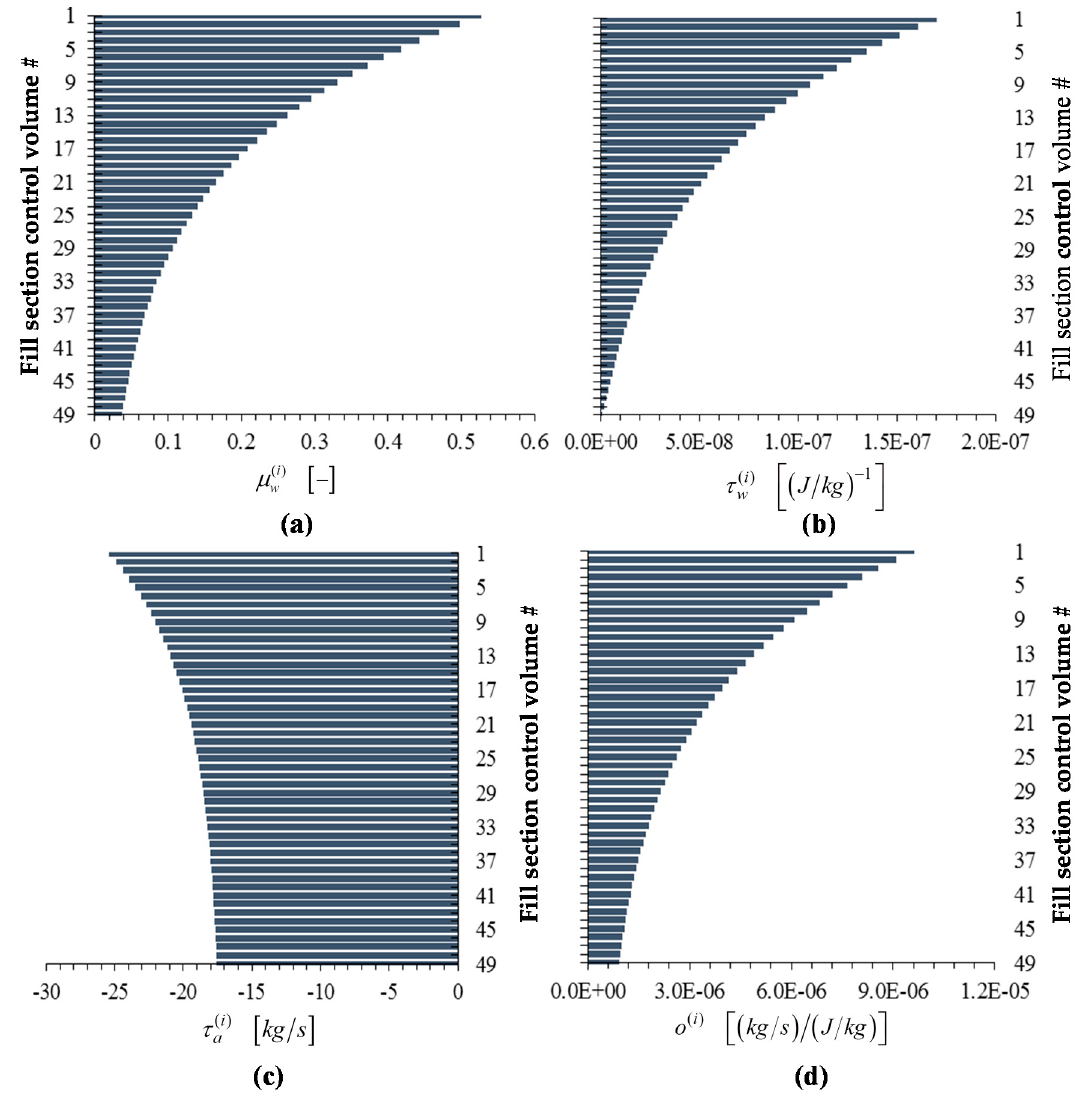
( 50 ) (50)  R m , as functions of the height of the w , as functions of the height of the w (cid:16) (cid:17) (cid:16) (cid:17) (cid:16) (cid:17) ( 1 ) ( 49 ) ( 1 ) ( 49 ) ( 1 ) ( 49 ) µ τ τ ; ( b ) τ w (cid:44) ; ( c ) τ a (cid:44) ; w ,..., µ w w ,..., τ w a ,..., τ a ( 50 ) − w , the value of the adjoint function µ a is